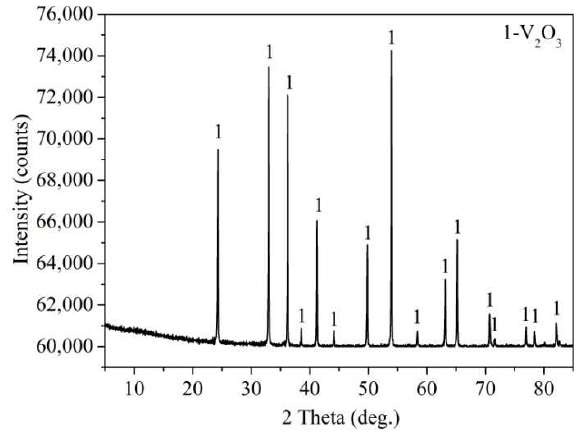
Figure 13. XRD pattern of the precipitates obtained from the actual concentrated vanadium solution. Table 5. Chemical composition of V 2 O 3 products, wt %.